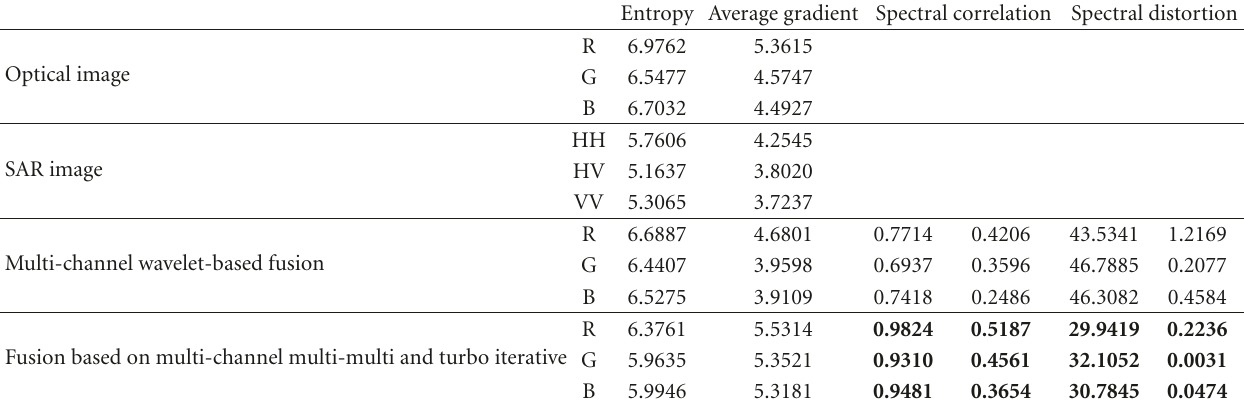
Figure 13: CFAR detection area on the source image and fusion result image, (a)optical image, (b) SAR image, (c) CFAR on source SAR image, (d) CFAR on wavelet-based fusion result, (e) CFAR on model-based fusion result and, (f) CFAR on turbo-based fusion result. Table 4: Quantitative indices for fusion